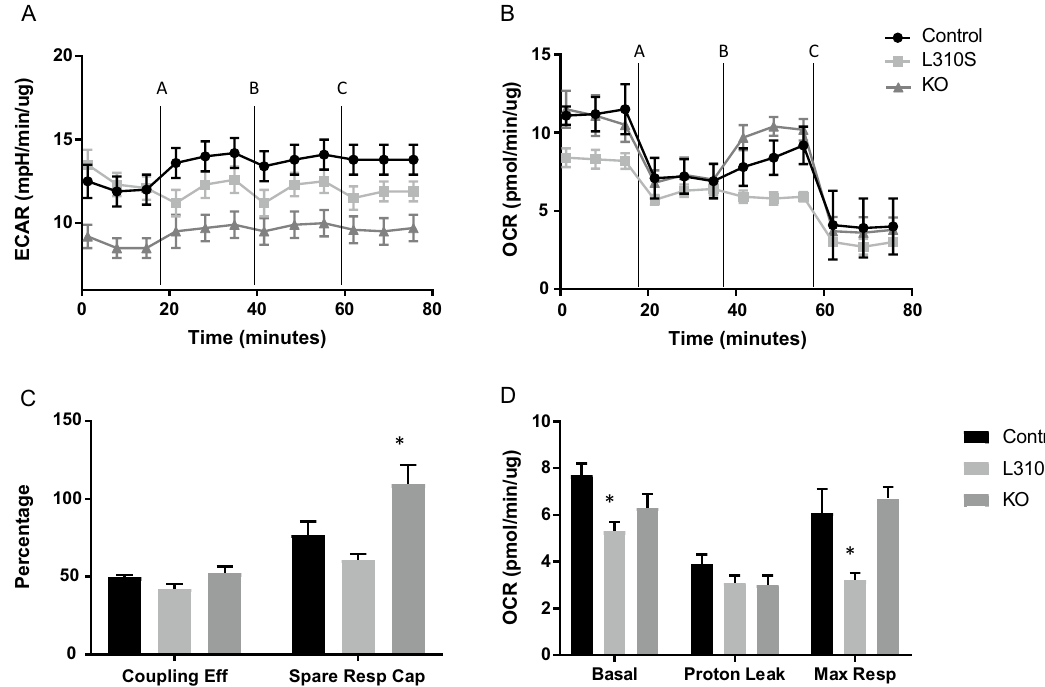
Figure 9. Evaluation of mitochondrial functionality in the CRISPR-Cas9 engineered cell lines through extracellular flux analysis with a mitochondrial stress test involving the addition of oligomycin A (2.5 µM) indicated at time interval A, addition of FCCP (2.0 µM) at time interval B and addition of Rotenone Antimycin A (0.5 µM) at time interval C. Black (circle) indicates control, light gray (square) indicates L310S line and dark gray (triangle) indicates KO line. * indicates p-value < 0.05. ( A ) Extracellular acidification rate (mpH/min/ µg) (ECAR) is a measurement of glycolysis in the mitochondrial stress test. The KO loss of function DPYD line demonstrates a significant reduction in the rate of glycolysis relative to the control and L310S line at all measured time intervals (adjusted p-value ≤ 0.0065). ( B ) Oxygen consumption rate (pmol/min/µg) (OCR) is a measure of mitochondrial respiration and L310S demonstrates a reduced rate of oxygen consumption at baseline and no increase in oxygen consumption with the addition of FCCP. The KO line demonstrates similar rates of oxygen consumption and responsiveness to too compounds, with the exception of the addition of FCCP. The KO line responds more rapidly to FCCP addition with a more significant increase in OCR. ( C ) There is no significant difference in coupling efficiency (Coupling Eff) across the three lines, but the KO line demonstrates a more significant increase in spare respiratory capacity (Spare Resp Cap) relative to the control line (adjusted p-value 0.0377). ( D ) The L310S line has a reduced basal OCR (adjusted p-value 0.0083) and a reduced rate of maximal respiration (Max Resp) (adjusted p-value 0.0201) relative to